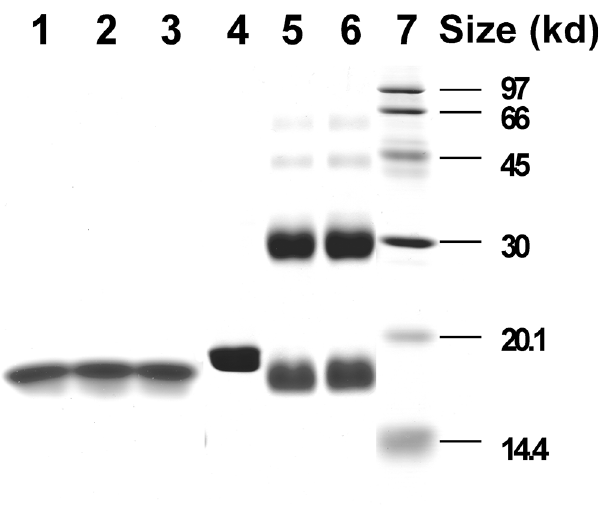
Fig 5. Chemical cross-linking of HMGA2 and HMGA2 Δ 95 – 108 with EDC. Chemical cross-linking reactions with EDC in MES buffer were performed as described under “ Materials and Methods. ” Cross-linked protein samples were analyzed by electrophoresis in a 15% SDS-PAGE gel and stained with Coomassie Brilliant Blue R-250. Lane 1 contained HMGA2 Δ 95 – 108 in the absence of EDC; lanes 2 and 3 contained 40 μ M HMGA2 Δ 95 – 108 in the presence of 2 mM EDC; lane 4 contained HMGA2 in the absence of EDC; lanes 5 and 6 contained 40 μ M HMGA2 in the presence of 2 mM EDC; lane 7 contained molecular standards.